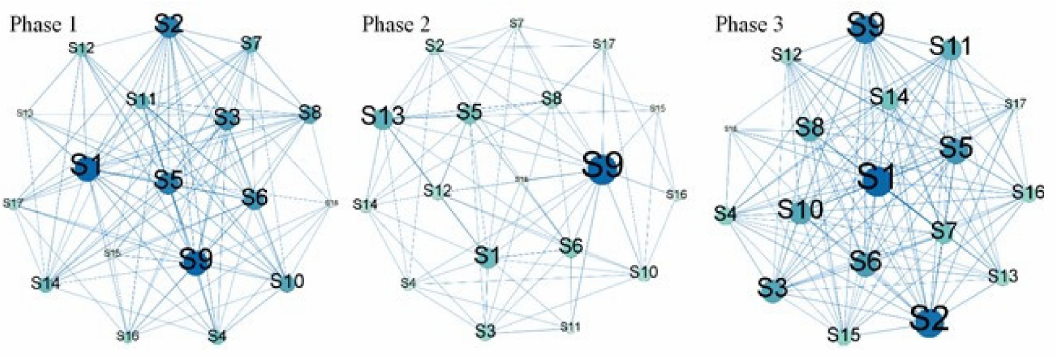
Figure 1. Social network graphs of the construction project before, during, and after the disaster.